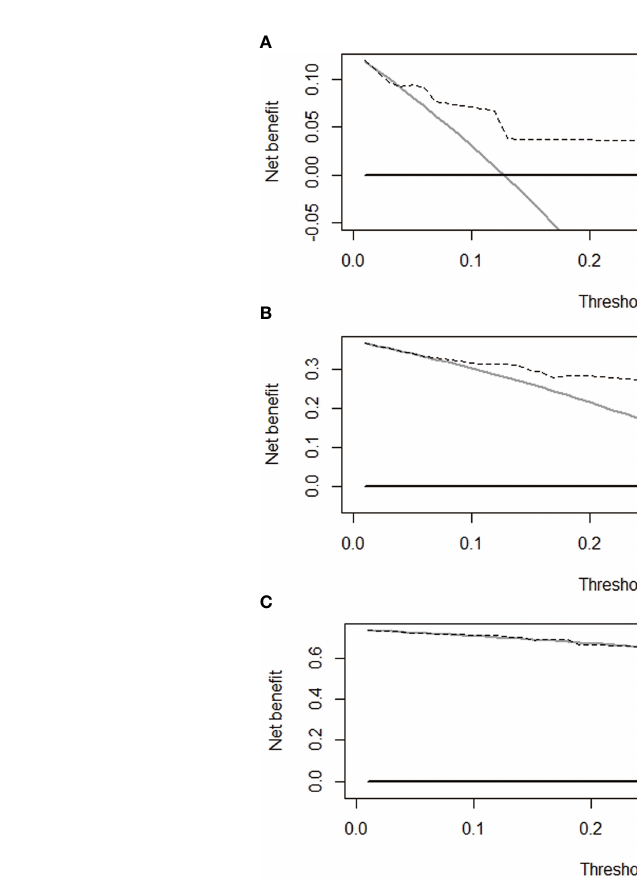
FIGURE 6 | Decision curves for the prediction of postoperative survival rates of PDAC patients at 6 months (A) , 1 year (B) , and 2 years (C)